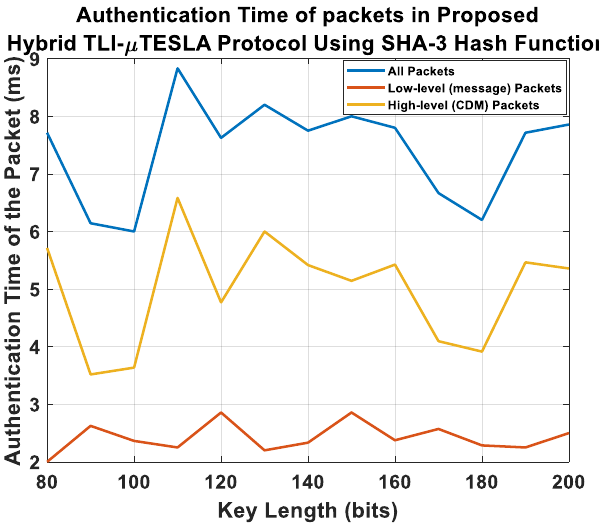
Figure 13. Simulation results showing the composition of the authentication time of the low-level (message) packets (red line), authentication time of the high-level CDM packets (yellow line), and overall authentication time of the packets (blue line) in the Proposed Hybrid TLI-µTESLA protocols using SHA-3 Hash Function.